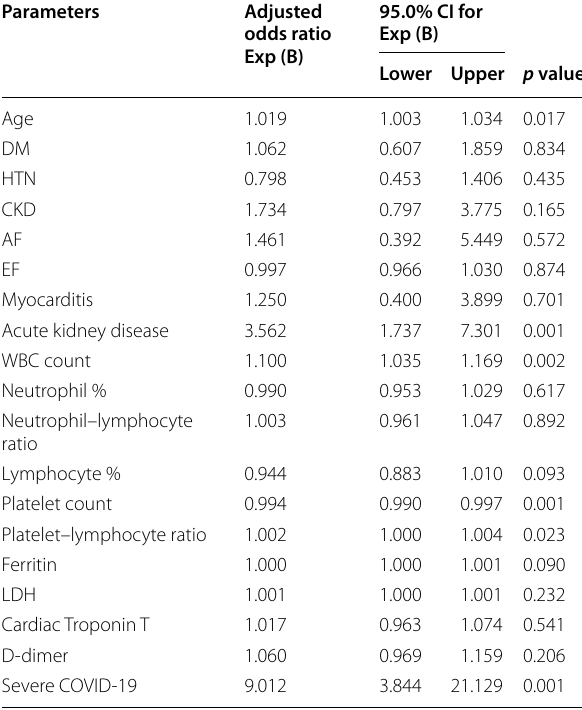
AF atrial fibrillation, CI confidence interval, CKD chronic kidney disease, DM diabetes mellitus, EF ejection fraction, HTN hypertension, LDH lactate dehydrogenase, WBC white blood